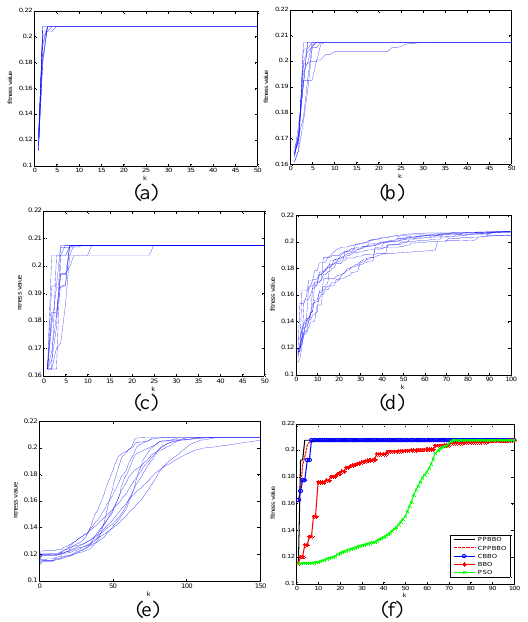
(f) Fig.6.Comparative results for case 1. (a)Evolution curves of PPBBO;(b) Evolution curves by of CPPBBO;(c)Evolution curves of CBBO;(d) Evolution curves of BBO;(e) Evolution curves of PSO;(f). Evolution curves in